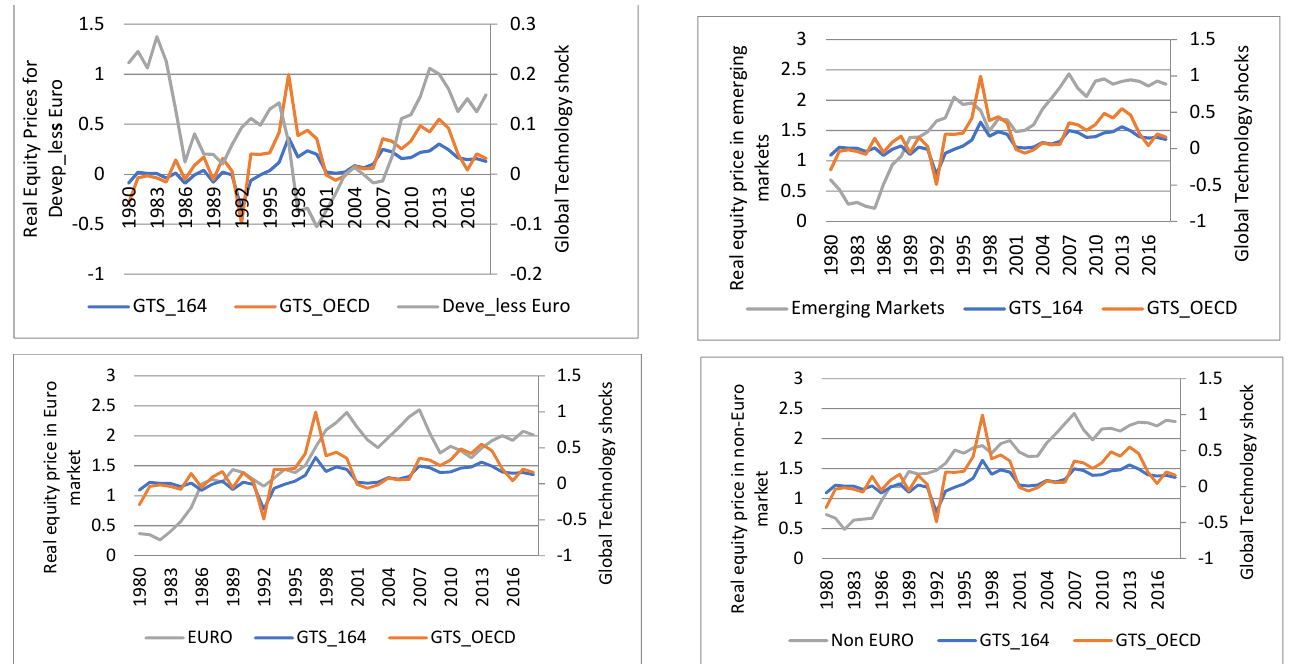
Figure A2. Region level co-movement of real equity price and technology shock. Note: GTS − 164 is the global technology shock for the group of 164 countries while GTS—OECD is for the shock computed for the group of OECD countries. Also, EURO indicates the European countries, Non − EURO indicates the Non − European countries, and Deve_less Euro indicates the other developed countries that are non − Euro.